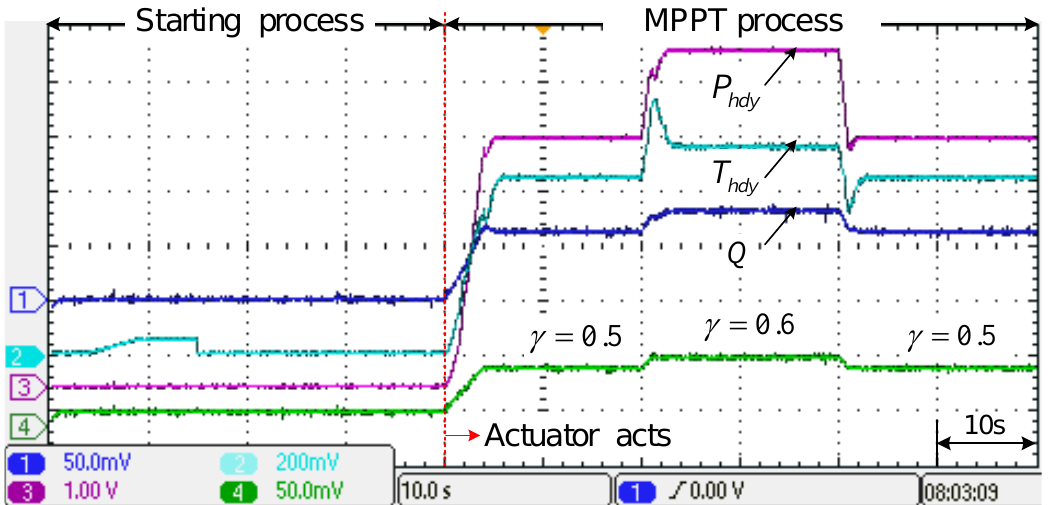
Figure 14. Hydraulic dynamics process in the real-time simulation, P hdy the generated hydraulic power (100 w/div), T hdy the turbine torque (2 N · m/div), Q the water flow rate (0.05 m 3